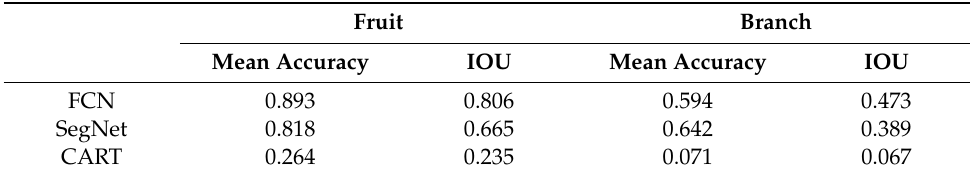
Table 1. Mean accuracy and intersection over union (IOU) of the FCN, SegNet, and classification and regression trees classifier (CART) over the test set.